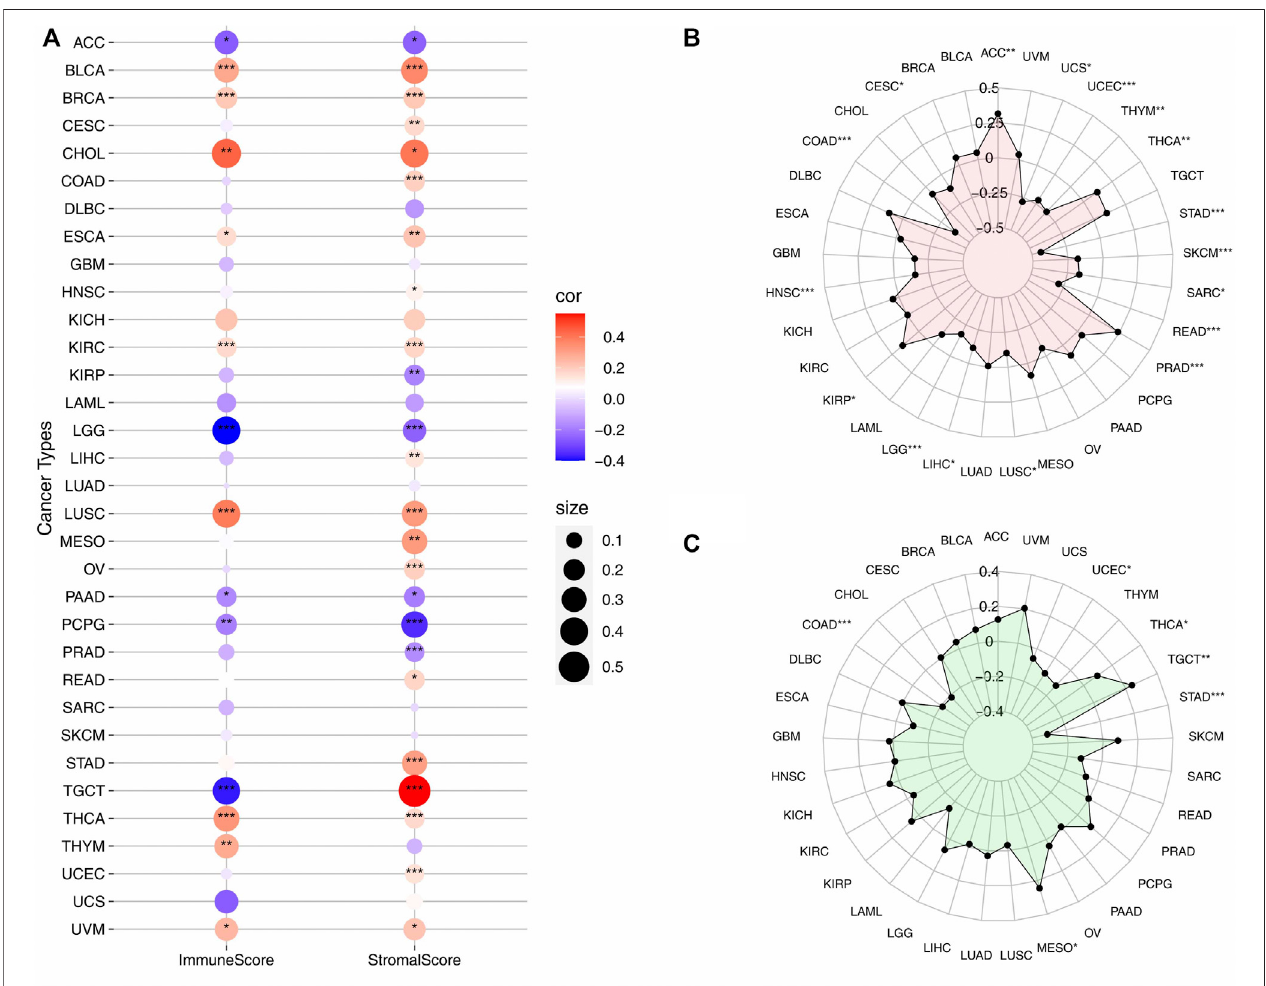
FIGURE 8 | Correlation between VSTM2L expression level and markers of the TIME and tumor prognosis. (A) Correlation between VSTM2L expression and ImmuneScore and StromalScore. The color and area of each circle represent the degree and direction of correlation, with larger circles corresponding to a stronger correlation and red and blue corresponding to a positive and negative correlation, respectively. (B,C) Correlation between VSTM2L expression level and TMB (B) and MSI (C) . * p < .05, ** p < .01, *** p < .001.